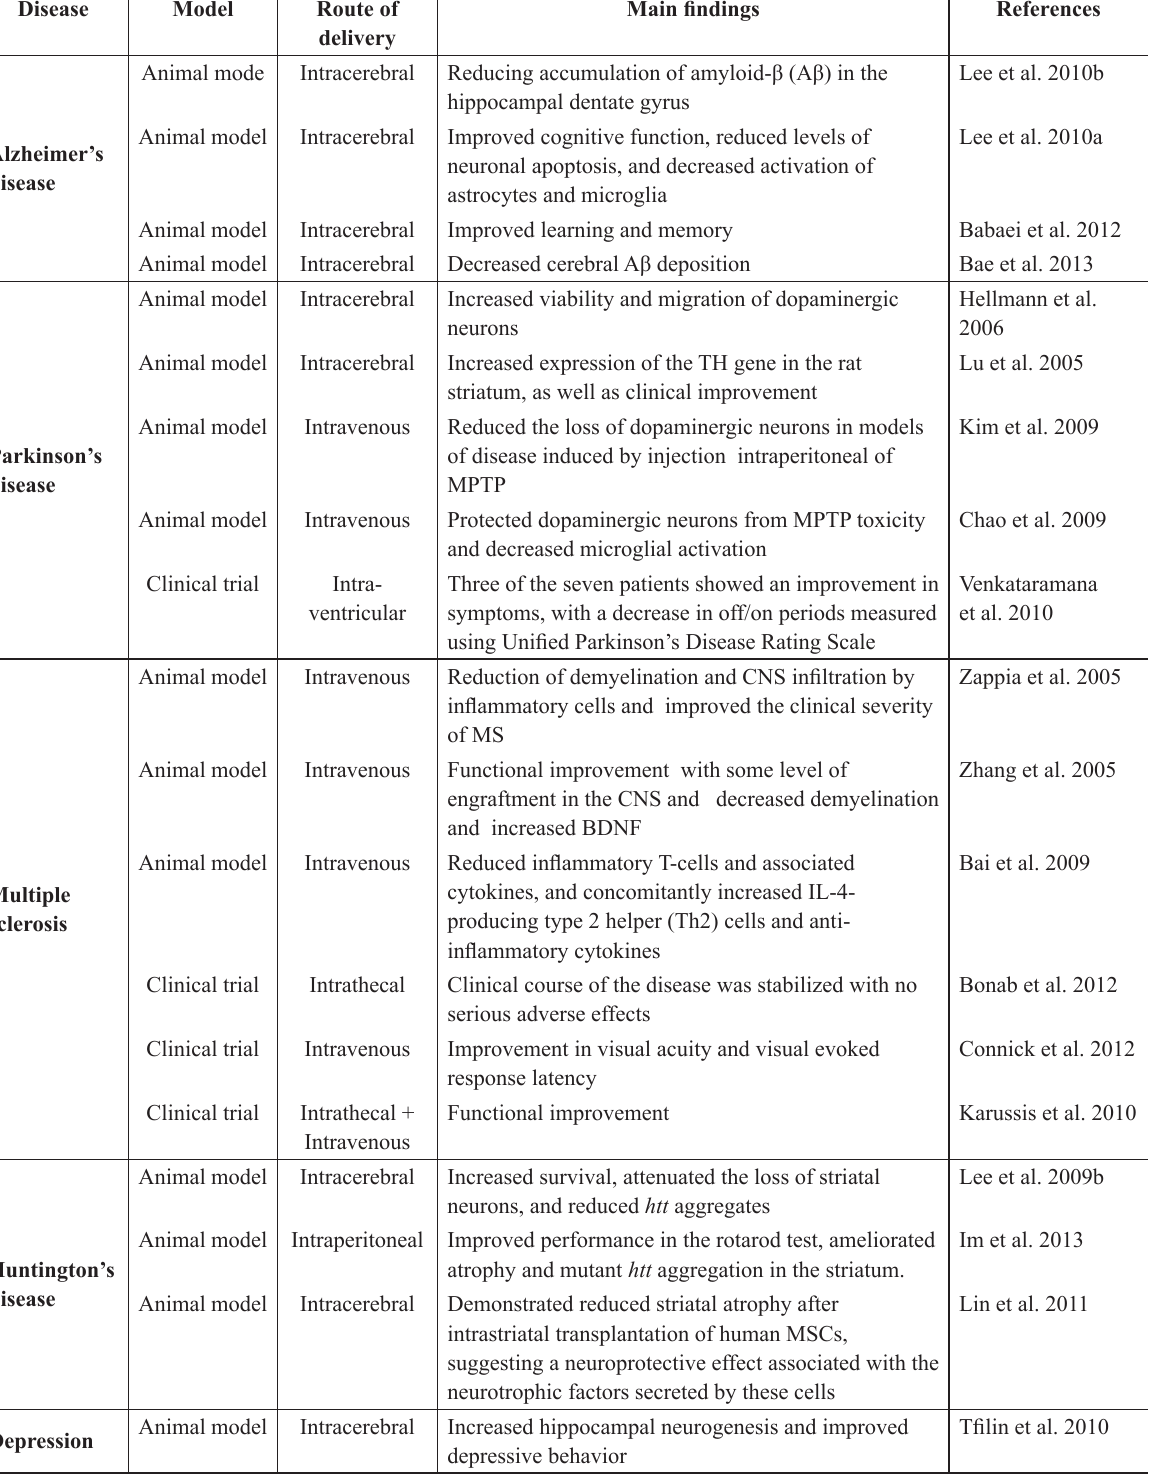
summary of the main results using MsCs application in neurodegenerative and psychiatric